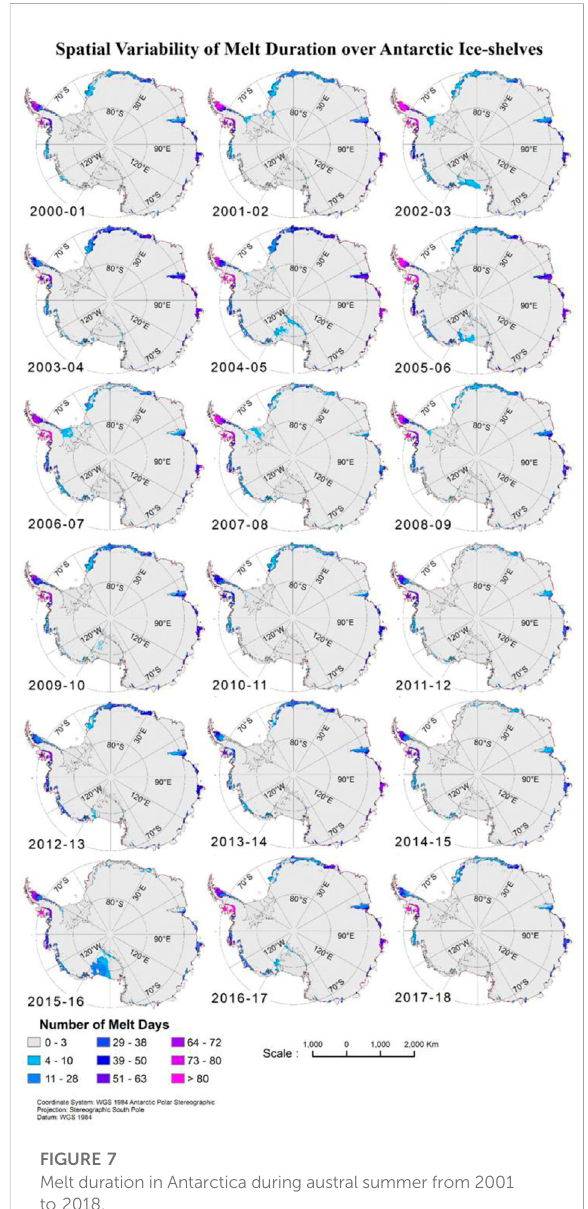
FIGURE 7 Melt duration in Antarctica during austral summer from 2001 to